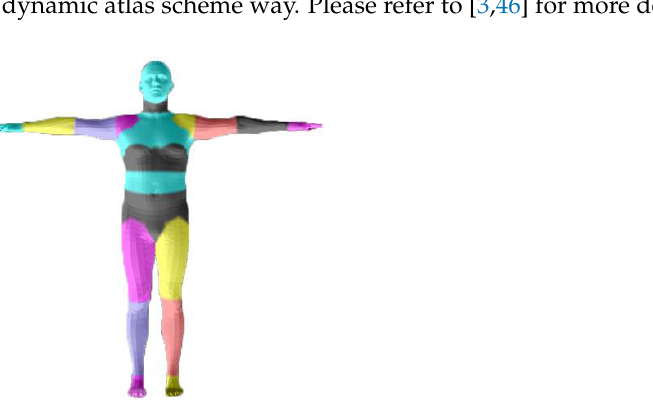
Figure 3. Human parsing label from inner body vertex segmentation.